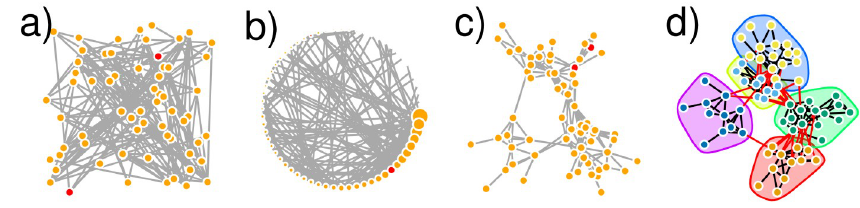
Fig 1. Four visualizations of the same network modeling interactions between 64 sociable weavers [14, 22]. (a–c) The same 2 nodes are colored in red to show that their distance varies depending on the layout. (a) Random layout. (b) Circle layout in which nodes’ size and position are defined by their degree. (c) Fruchterman and Reingold layout, showing 3 apparent clumps on top and bottom right and left. (d) Kamada and Kawai layout set with weights on edges (in red) connecting the 5 clusters obtained with the Louvain algorithm (see Tip 6 and [23] for details). The clusters are delineated by different colours. Performed with the R package igraph.